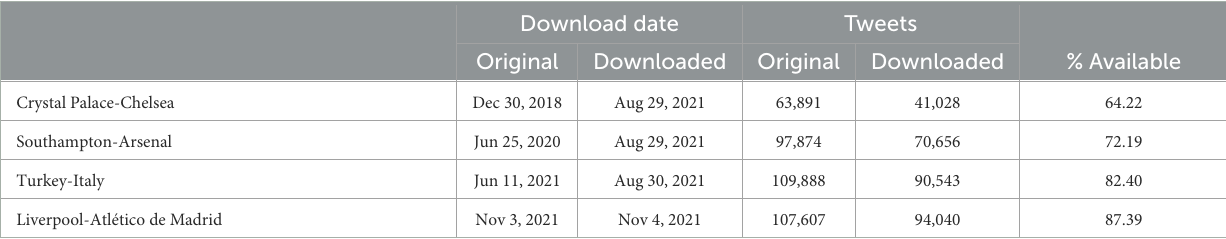
TABLE 3 Statistics about the original datasets, and the same datasets downloaded anew after a period of time.